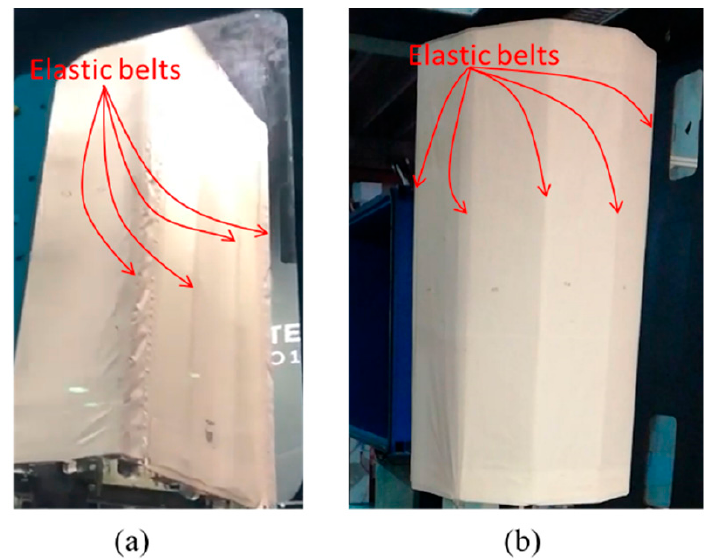
Figure 1. Squared ( a ) and decagonal ( b ) structures under test.